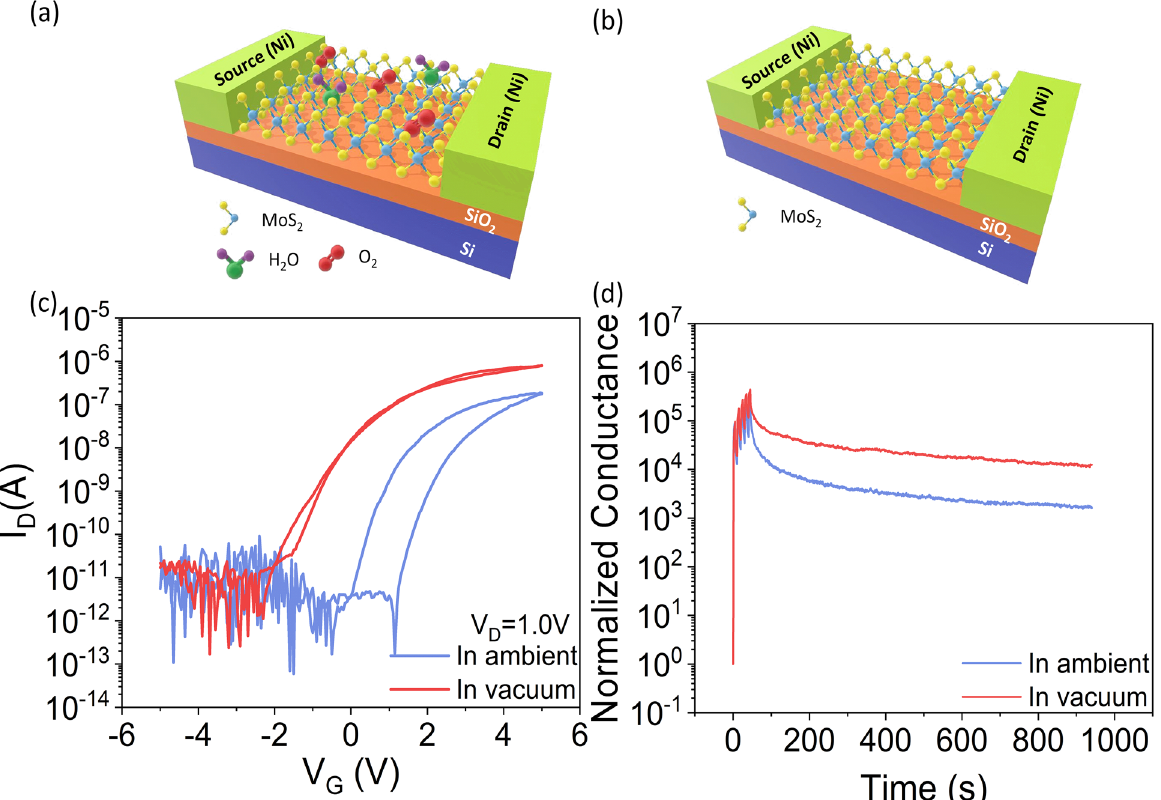
Figure 4. Schematic of CVD grown monolayer MoS 2 FET in ( a ) ambient and ( b ) vacuum condition. ( c ) Comparison of I D –V G at V D = 1.0 V in ambient and in vacuum. ( d ) Comparison of potentiation and conductance retention at V D = 1.0 V and V G = V Threshold – 0.5 V of MoS 2 FET in ambient and in